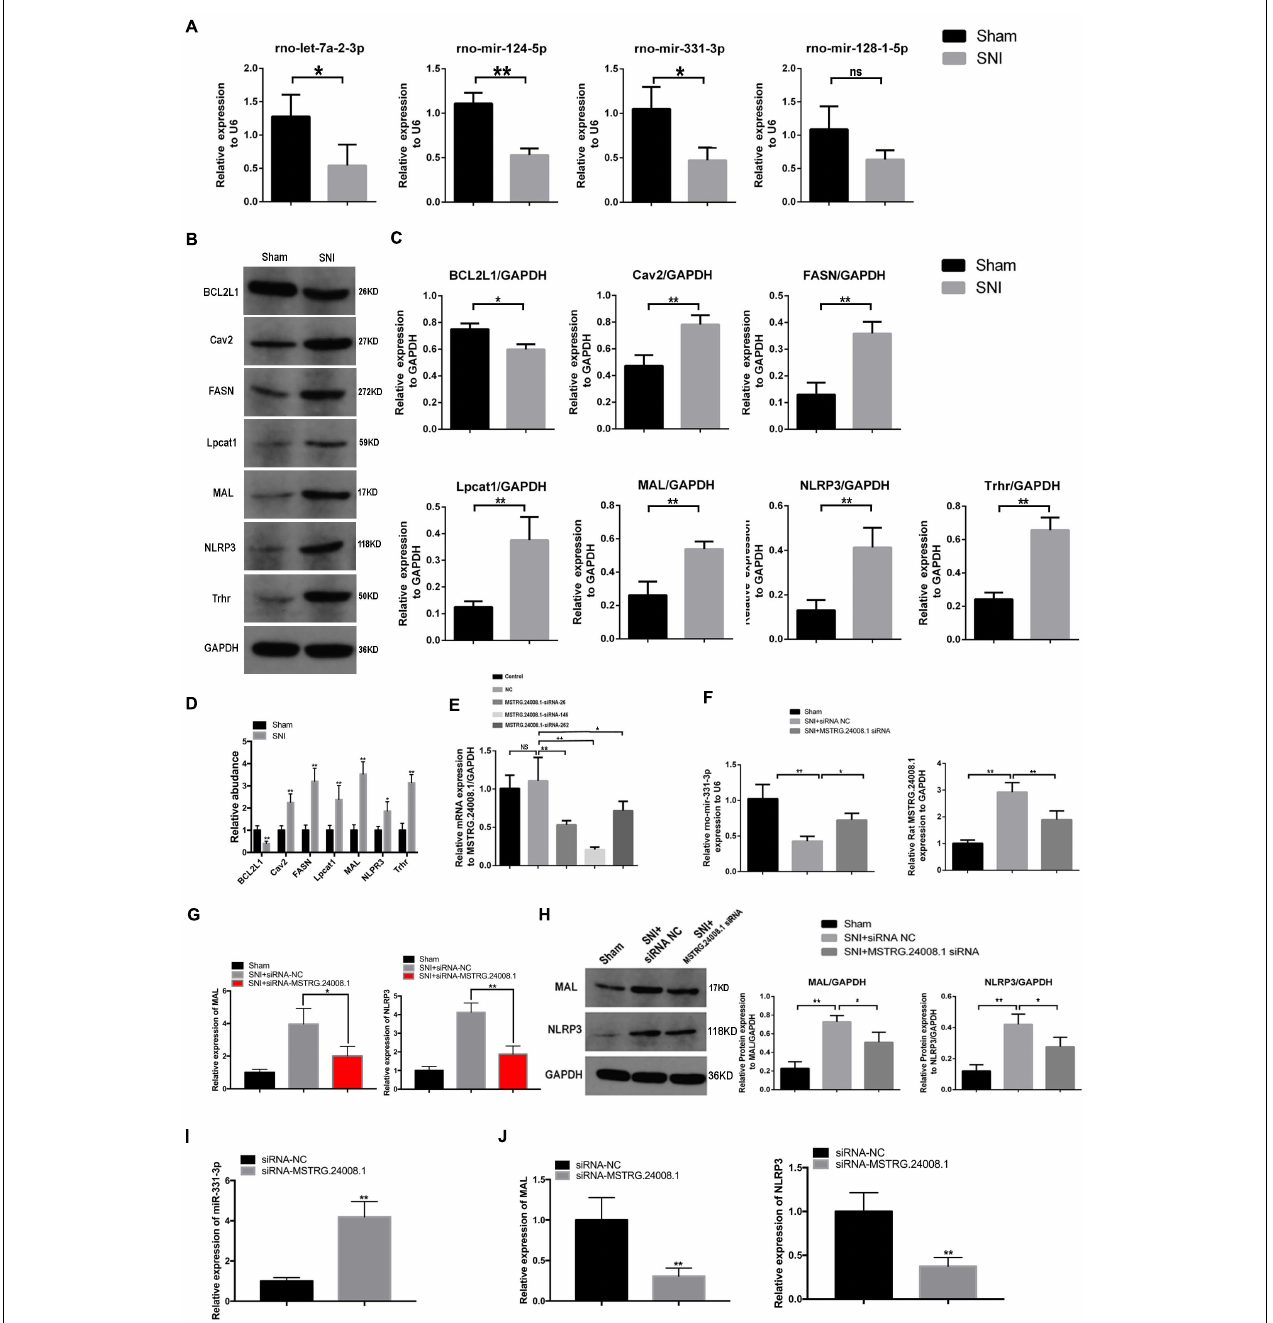
FIGURE 2 | lncRNAs, miRNA, and relative protein levels changed after sciatic nerve injury. (A) qRT-PCR analysis showed decreased expression of miRNAs after sciatic nerve injury. Student’s t -test, * P < 0.05, ** P < 0.01. Data are presented as the means ± SD. (B) Western blotting analysis of protein levels (BCL2L1, Cav2, FASN, Lpcat1, MAL, NLRP3, and Trhr) after sciatic nerve injury. (C) The relative protein levels on the western blots shown in (B) as measured using gray value analysis. Student’s t -test, * P < 0.05, ** P < 0.01. Data are presented as the means ± SD. (D) qRT-PCR analysis showed the mRNA (BCL2L1, Cav2, FASN, Lpcat1, MAL, NLRP3, and Trhr) expression in the sciatic nerve tissue of the Sham and SNI groups. (E) qRT-PCR analysis showed the effects of different siRNAs on MSTRG.24008.1 expression. One-Way ANOVA, * P < 0.05, ** P < 0.01. Data are presented as the means ± SD. (F) qRT-PCR analysis showed the expression of miRNA-331-3p and MSTRG.24008.1 were regulated by different siRNAs targeting on MSTRG.24008.1. Student’s t -test, * P < 0.05, ** P < 0.01. Data are presented as the means ± SD. (G) The mRNA expression level of MAL and NLRP3 were affected by the siRNA targeting MSTRG.24008.1 after sciatic nerve injury. (H) The protein levels of MAL and NLRP3 were affected by the siRNA targeting MSTRG.24008.1 after sciatic nerve injury, as analyzed using western blotting. (I) The expression level of miR-331-3p was affected by the siRNA targeting MSTRG.24008.1 . (J) The mRNA expression level of MAL and NLRP3 were affected by the siRNA targeting MSTRG.24008.1